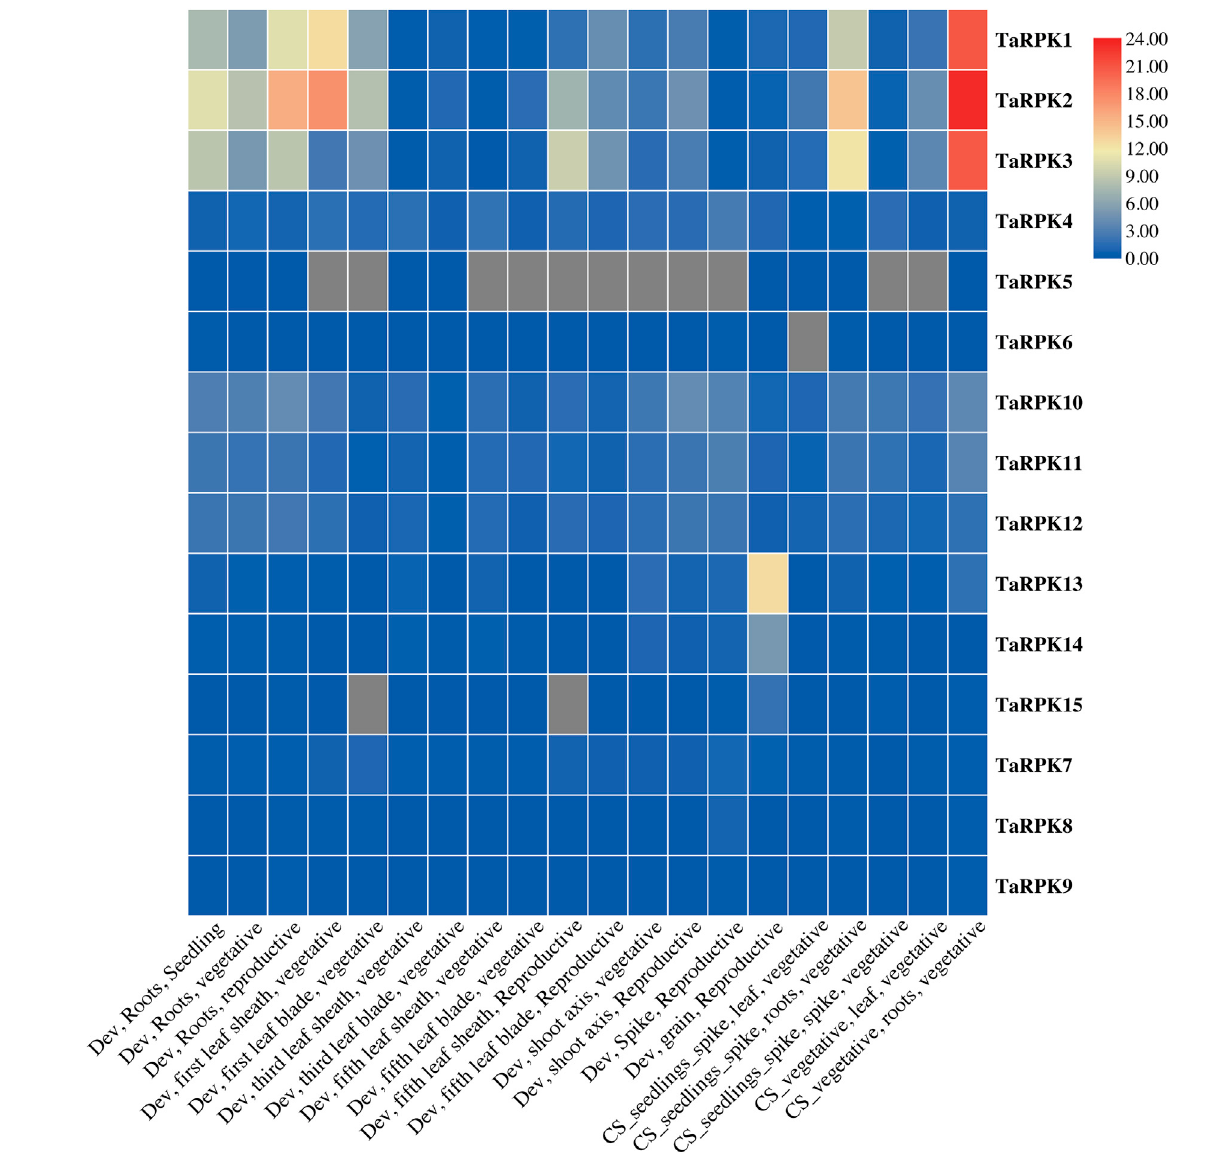
Frontiers in Genetics |